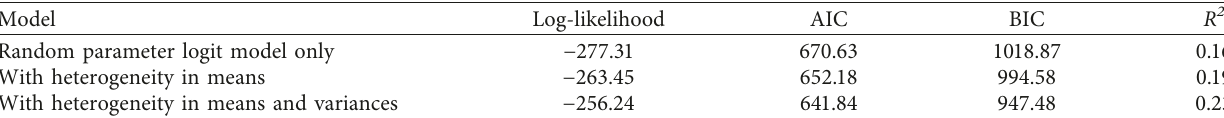
Table 4: Goodness-of-fit measure of random parameter logit approaches for